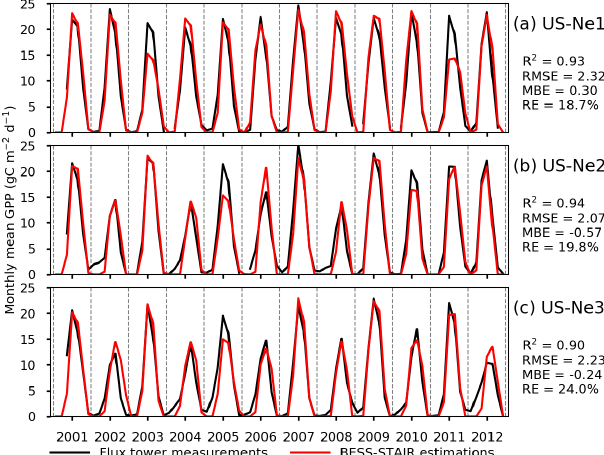
Figure A2. Time series of monthly mean GPP from flux-tower mea- surements and BESS-STAIR estimations. Significant underestima- tions in 2003 and 2011 for Ne1, in 2005 for Ne2, and in 2005 for Ne3 are due to misclassification of corn as soybean in CDL. Signif- icant overestimations in 2006 for Ne2 are due to misclassification of soybean as corn in